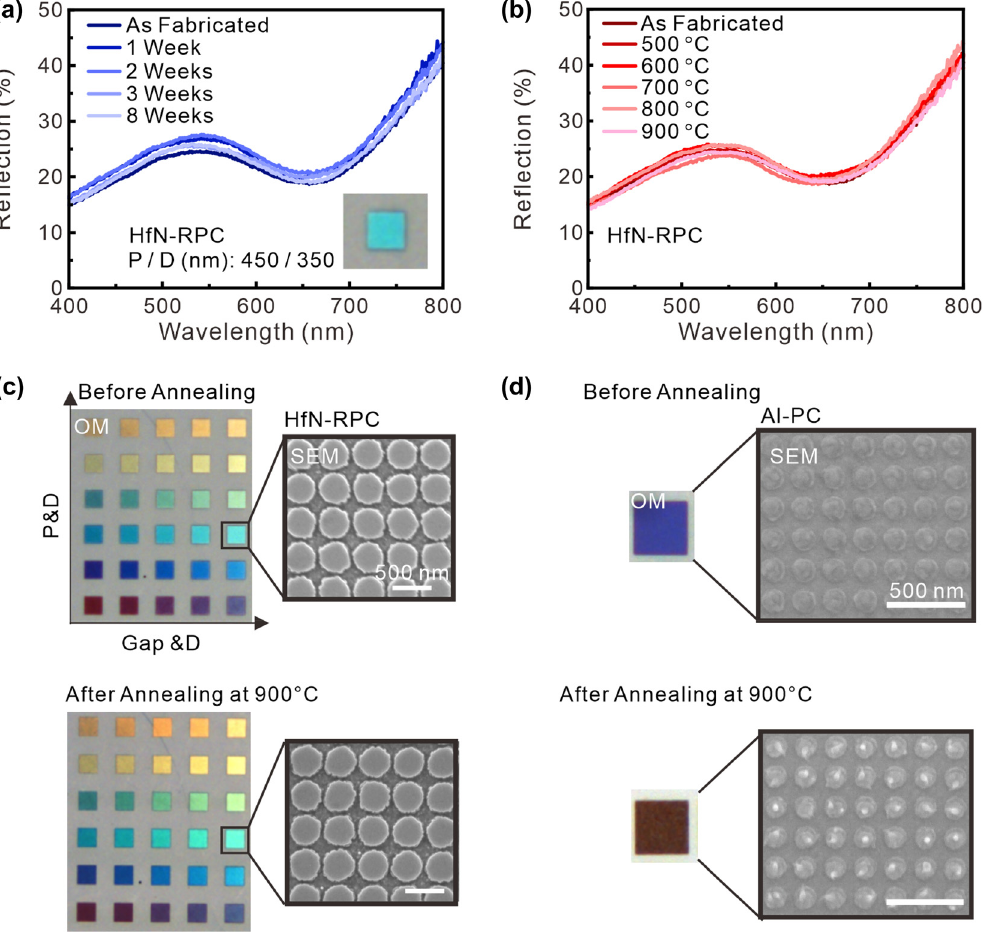
Figure 4: Refractory properties and stability of HfN refractory plasmonic crystals (RPC). (a) The measured reflection spectrum of the HfN RPC remains the same as a function of time, implying no sample degradation under ambient conditionsaftertwo months.(b)MeasuredreflectionspectraoftheHfNRPCafterheatingat 500 ° C – 900 ° C for40min,revealingnosigni fi cant variation versus the reference spectrum measured before annealing. (c) Optical images and SEM images of plasmonic HfN RPC and corresponding SEM images before annealing and after 900 ° C annealings. (d) Optical images and SEM images of Al-based plasmonic crystals (PC) as a counterpart before and after annealing at 900 ° C. The re fl ection color and the shape of the nanodisks change signi fi cantly after the heat